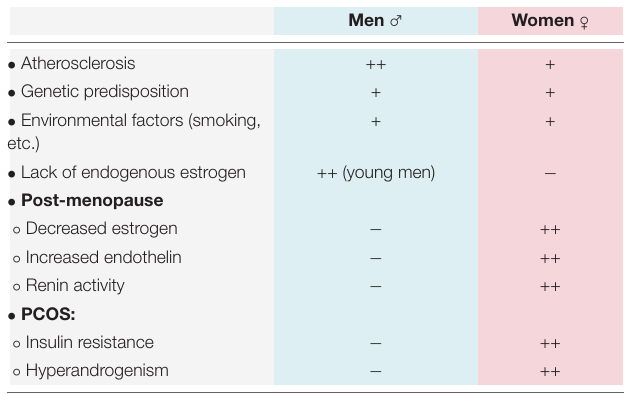
TABLE 2 | Pathophysiology of hypertension in men and